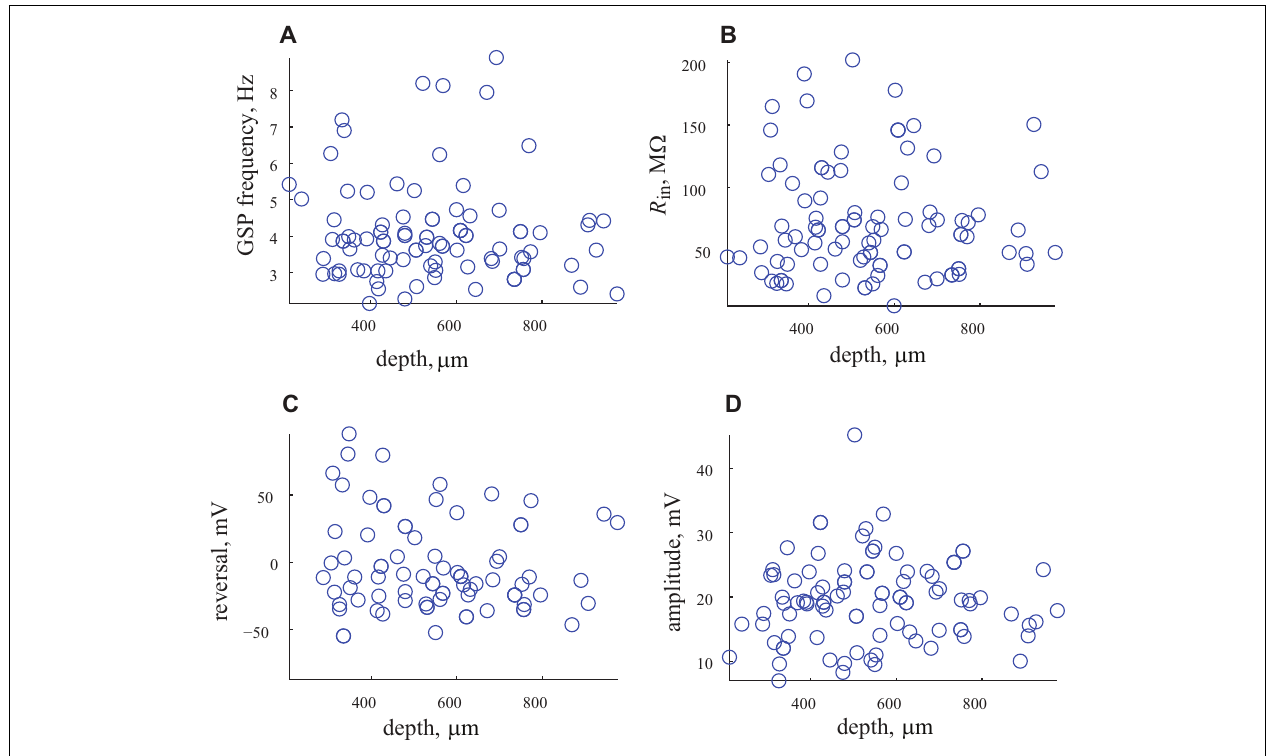
FIGURE 6 |The depth of recording does not affect the measured parameters. (A) The frequency of appearance of GSP vs. depth of recording. (B) R in vs. the depth of recording. (C) Reversal potential vs. depth of recording. (D) Amplitude of GSP vs. depth of recording. Note that none of the parameters are correlated with the depth of recording.